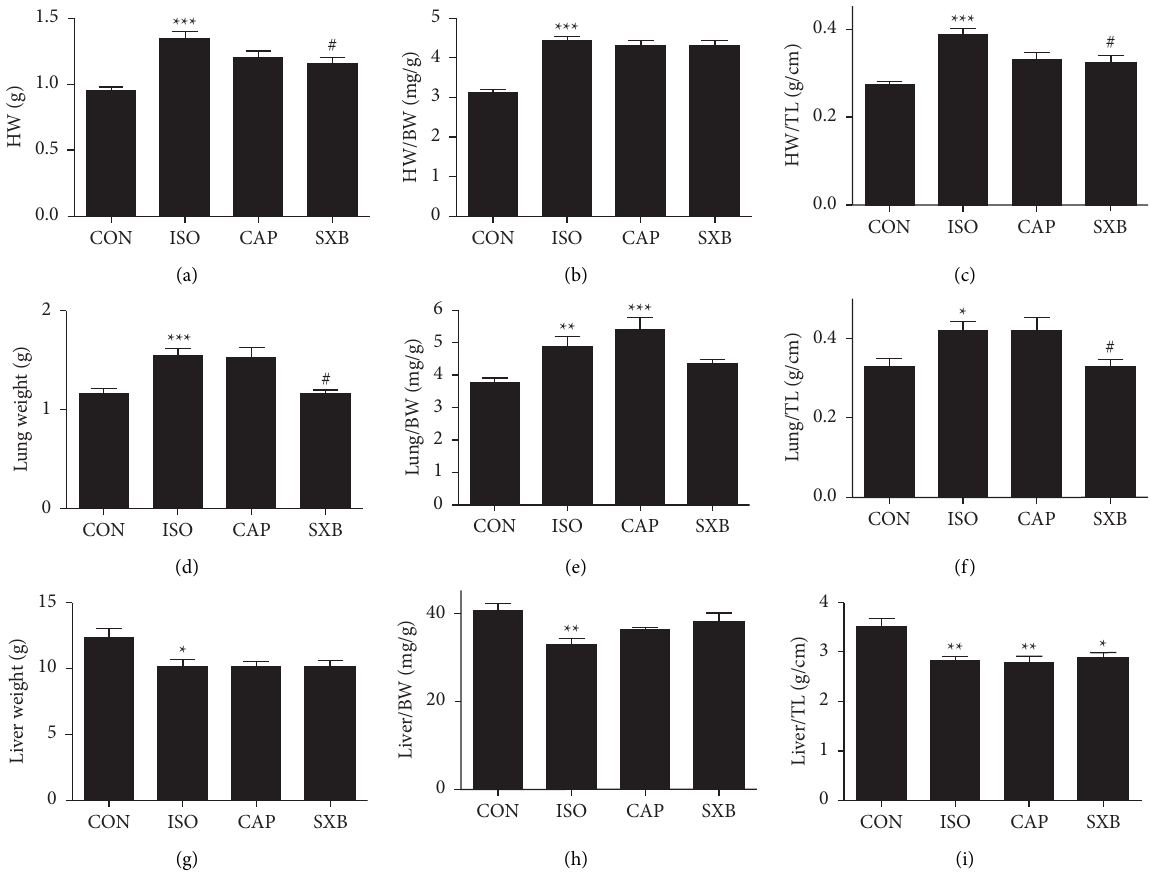
Figure 3: Anatomic data among the CON, ISO, CAP, and SXB groups. (a) HW, (b) HW/BW, (c) HW/TL, (d) lung weight, (e) lung/BW, (f) lung/TL, (g) liver weight, (h) liver/BW, and (i) liver/TL were compared among the CON ( n � 13), ISO ( n � 13), CAP ( n � 7), and SXB groups ( n � 9). ∗ P < 0 . 05, ∗∗ P < 0 . 01, ∗∗∗ P < 0 . 001, vs. the CON group. # P < 0 . 05, ## P < 0 . 01, ### P < 0 . 001, vs. the ISO group.